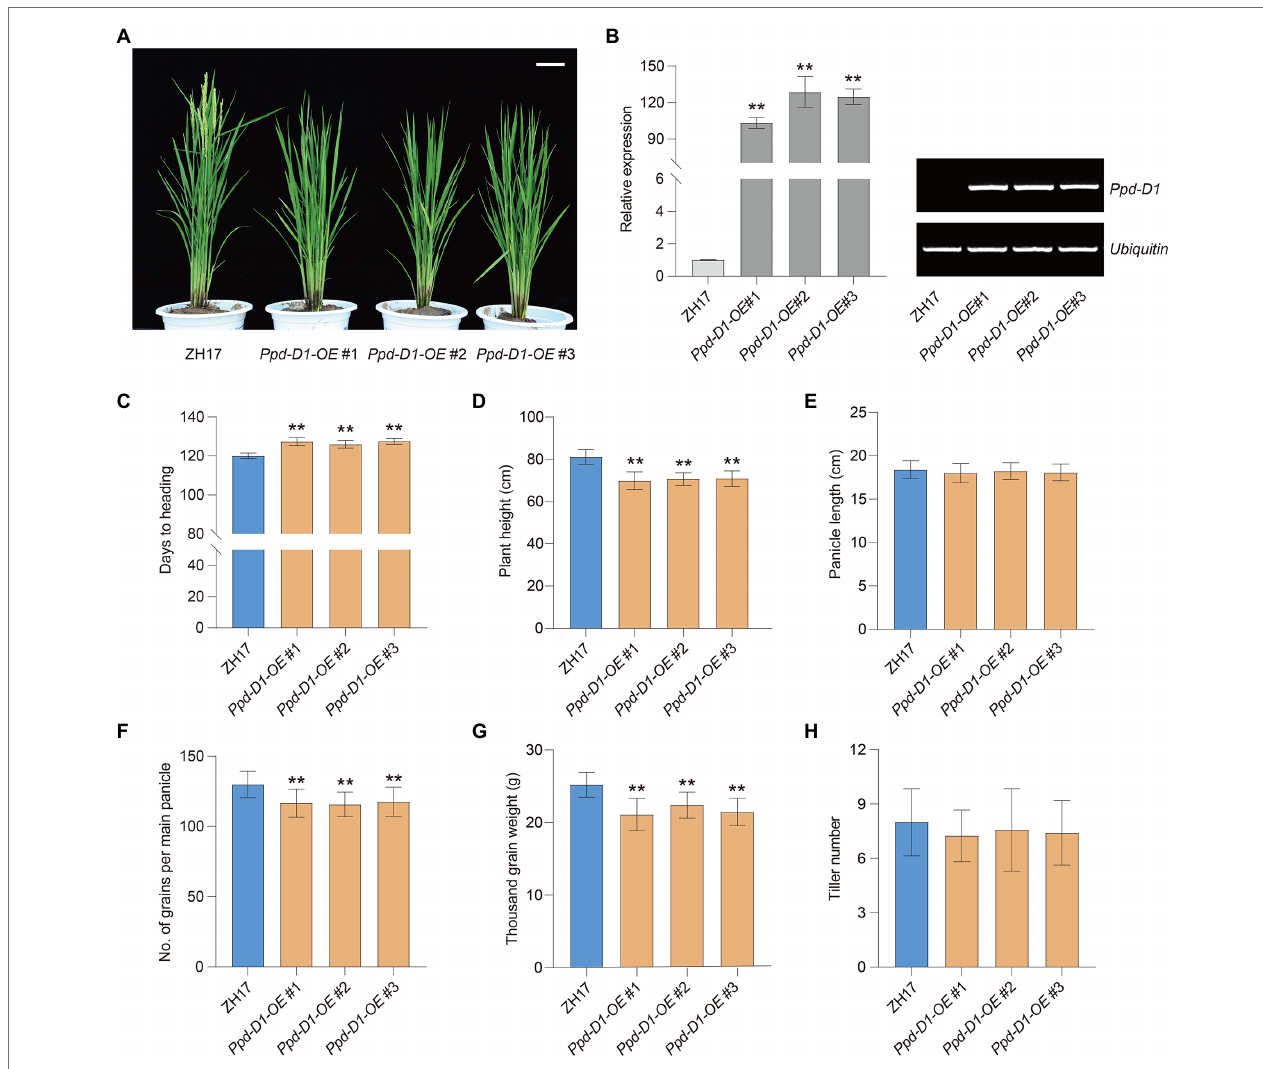
FIGURE 6 | Overexpression of Ppd-D1 affects rice yield-related traits. (A) Plant phenotypic comparison between wild-type Zhonghua 17 (ZH17) and Ppd-D1-OE transgenic lines. Scale bars = 10 cm. (B) qPCR (left) and RT-PCR (right) analysis of Ppd-D1 expression in ZH17 and Ppd-D1-OE transgenic lines. The rice Ubiquitin gene was used as an internal control. Values are presented as mean ± SD of three independent experiments. (C–H) Comparison of days to heading, plant height, panicle length, number of grains per main panicle, thousand-grain weight, and tiller number between ZH17 and Ppd-D1-OE transgenic lines (for each line, n = 12). Values are presented as mean ± SD. Phenotypic measurements of the transgenic plants were performed using three independent transgenic lines. Tukey’s test was performed between control and transgenic plants (** p <